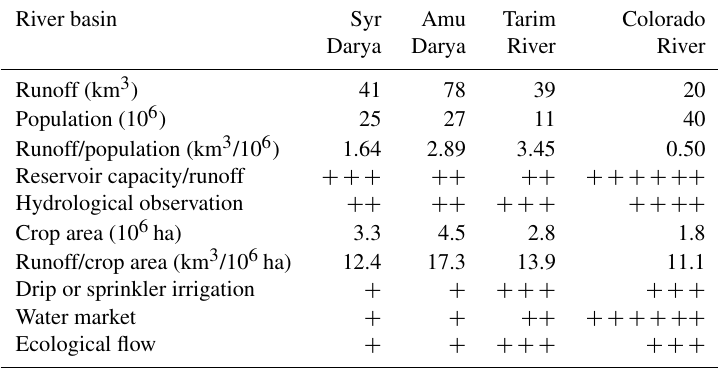
Table 4. Comparison of four river basins in the arid